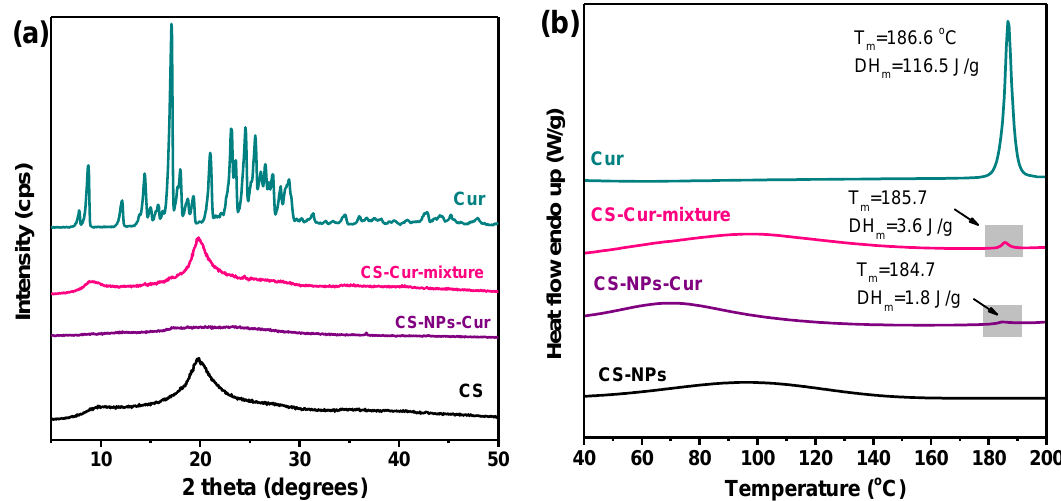
Figure 3. ( a ) XRD diffractograms and ( b ) DSC thermograms of CS, CS-Cur-NPs, and Cur.